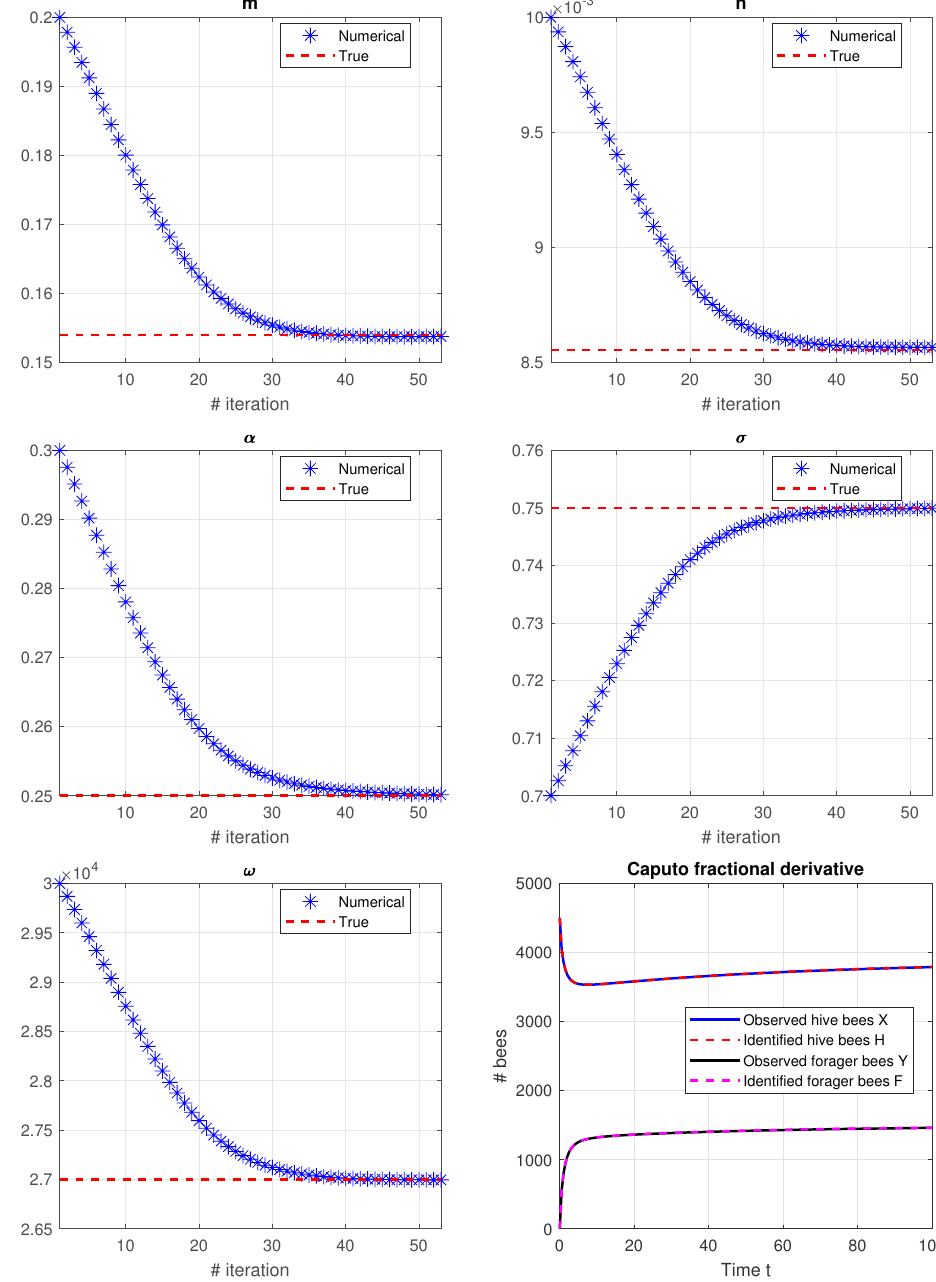
Figure 4. The convergence of ppp = ( m , n , α , σ , ω ) (cid:62) and the implied population dynamics ( bottom right